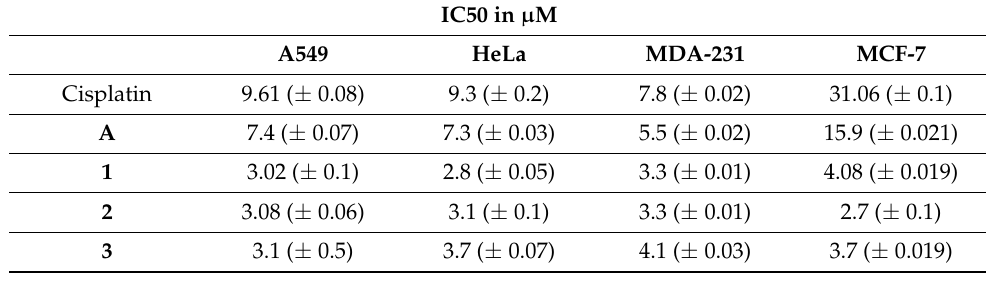
Table 4. IC 50 values ( µ M) of cisplatin and gold(III) compounds ( A , 1 – 3 ) against A549, HeLa, MDA- 231, and MCF-7 cancer cell lines.